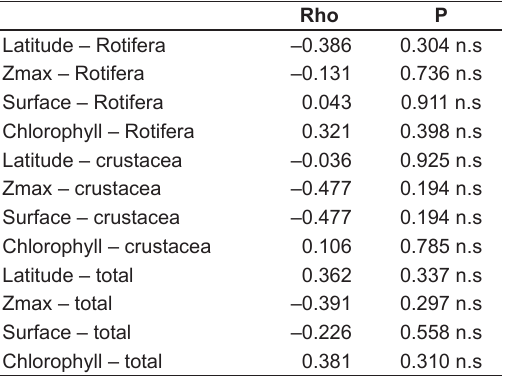
Table 3. Results of correlation between studied parameters with Rotifera, crustacean and total species